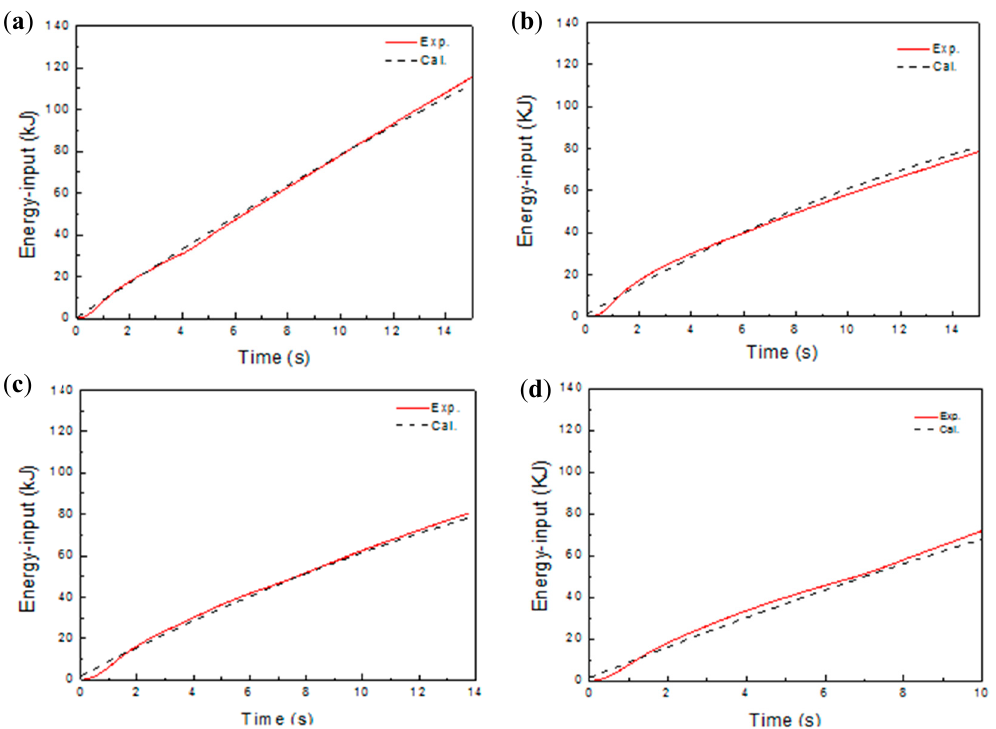
Figure 13. Comparison between calculated and experimental values of energy-input under welding parameters of ( a ) p = 200 MPa, N = 1400 rpm; ( b ) p = 80 MPa, N = 1200 rpm; ( c ) p = 100 MPa, N = 1500 rpm; and ( d ) p = 140 MPa, N = 1500 rpm.